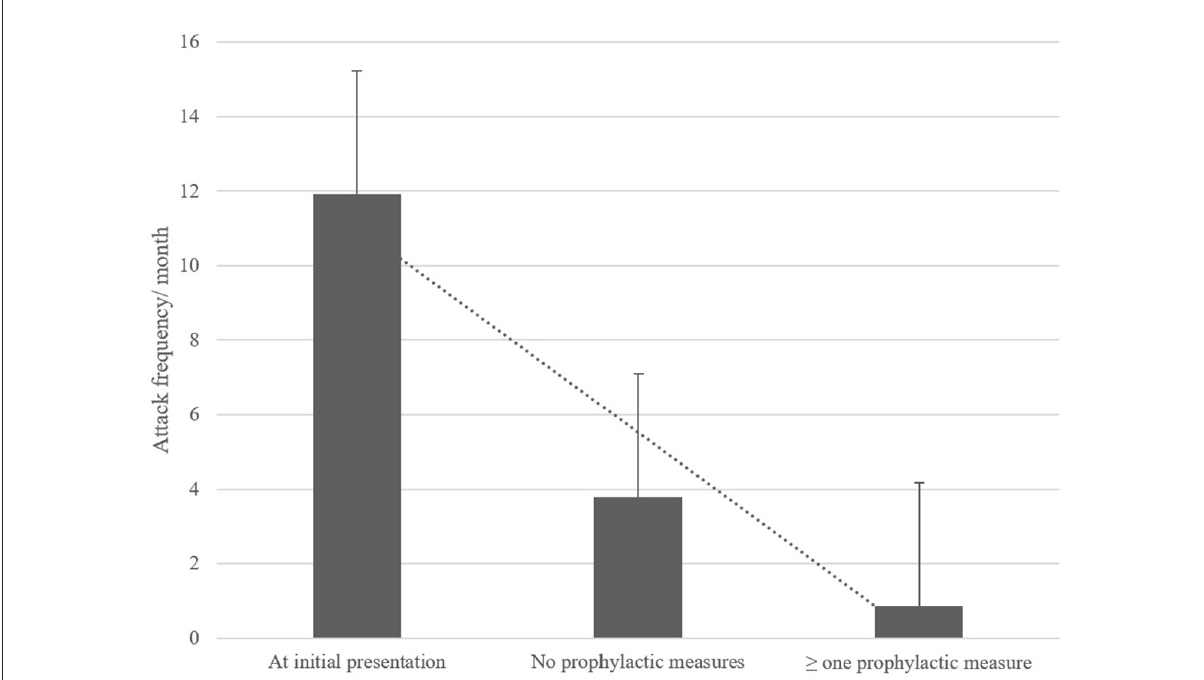
FIGURE2 Comparison of attack frequency per month at initial presentation and at follow-up with and without the implementation of prophylactic measures. These measures included regular exercise, increased fluid intake, sleep hygiene, relaxation exercises, daily intake of weight-adapted magnesium. Attacks significantly reduced over time, especially with prophylactic